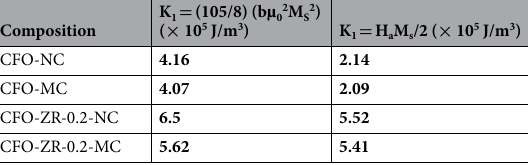
Table 1. Comparison of anisotropy constant estimated from law of approach to saturation and from torque curves.